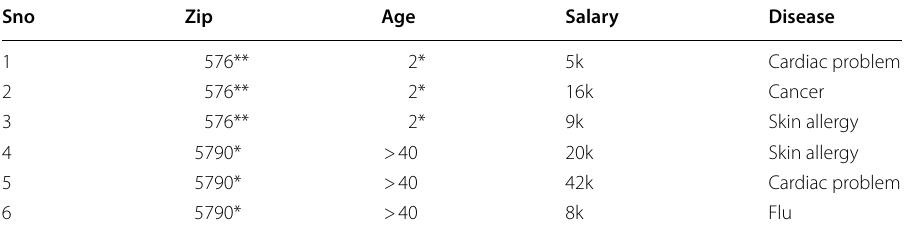
Table 4 T closeness privacy preservation